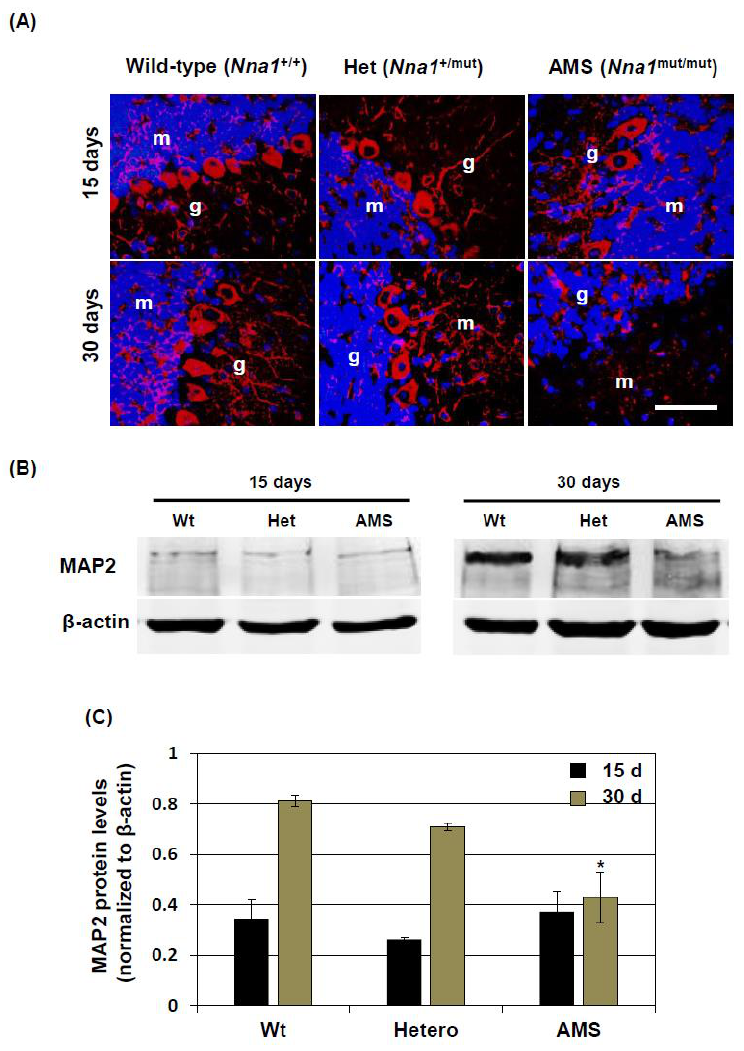
Figure 7. MAP2 protein expression in the cerebellum of AMS mice: The protein expression of MAP2 was evaluated by immunofluorescence staining and Western blotting. ( A ) Representative photomicrographs of MAP2 immunofluorescence staining of wild-type, Nna1 mutation heterozygous (Het), and AMS mice cerebellum at 15 (upper row) and 30 (lower row) days of age are shown. Nuclei were stained with Hoechst. m = molecular layer, g = granular layer. ( B , C ) MAP2 expression was further evaluated by Western blotting. ( B ) Representative MAP2 Western blotting results of cerebellar samples from wild-type (Wt), Nna1 mutation heterozygous (Het), and AMS mice at 30 days of age are shown here. β -actin served as a loading control. ( C ) MAP2 protein levels at 15 and 30 days of age were quantified by densitometry, and the data normalized to β -actin are shown here. Numerical data are presented as averages ± SD of 5 mice in each group. Statistical significance is denoted as follows: * p < 0.05 vs. wild type. Scale bar = 50 µ